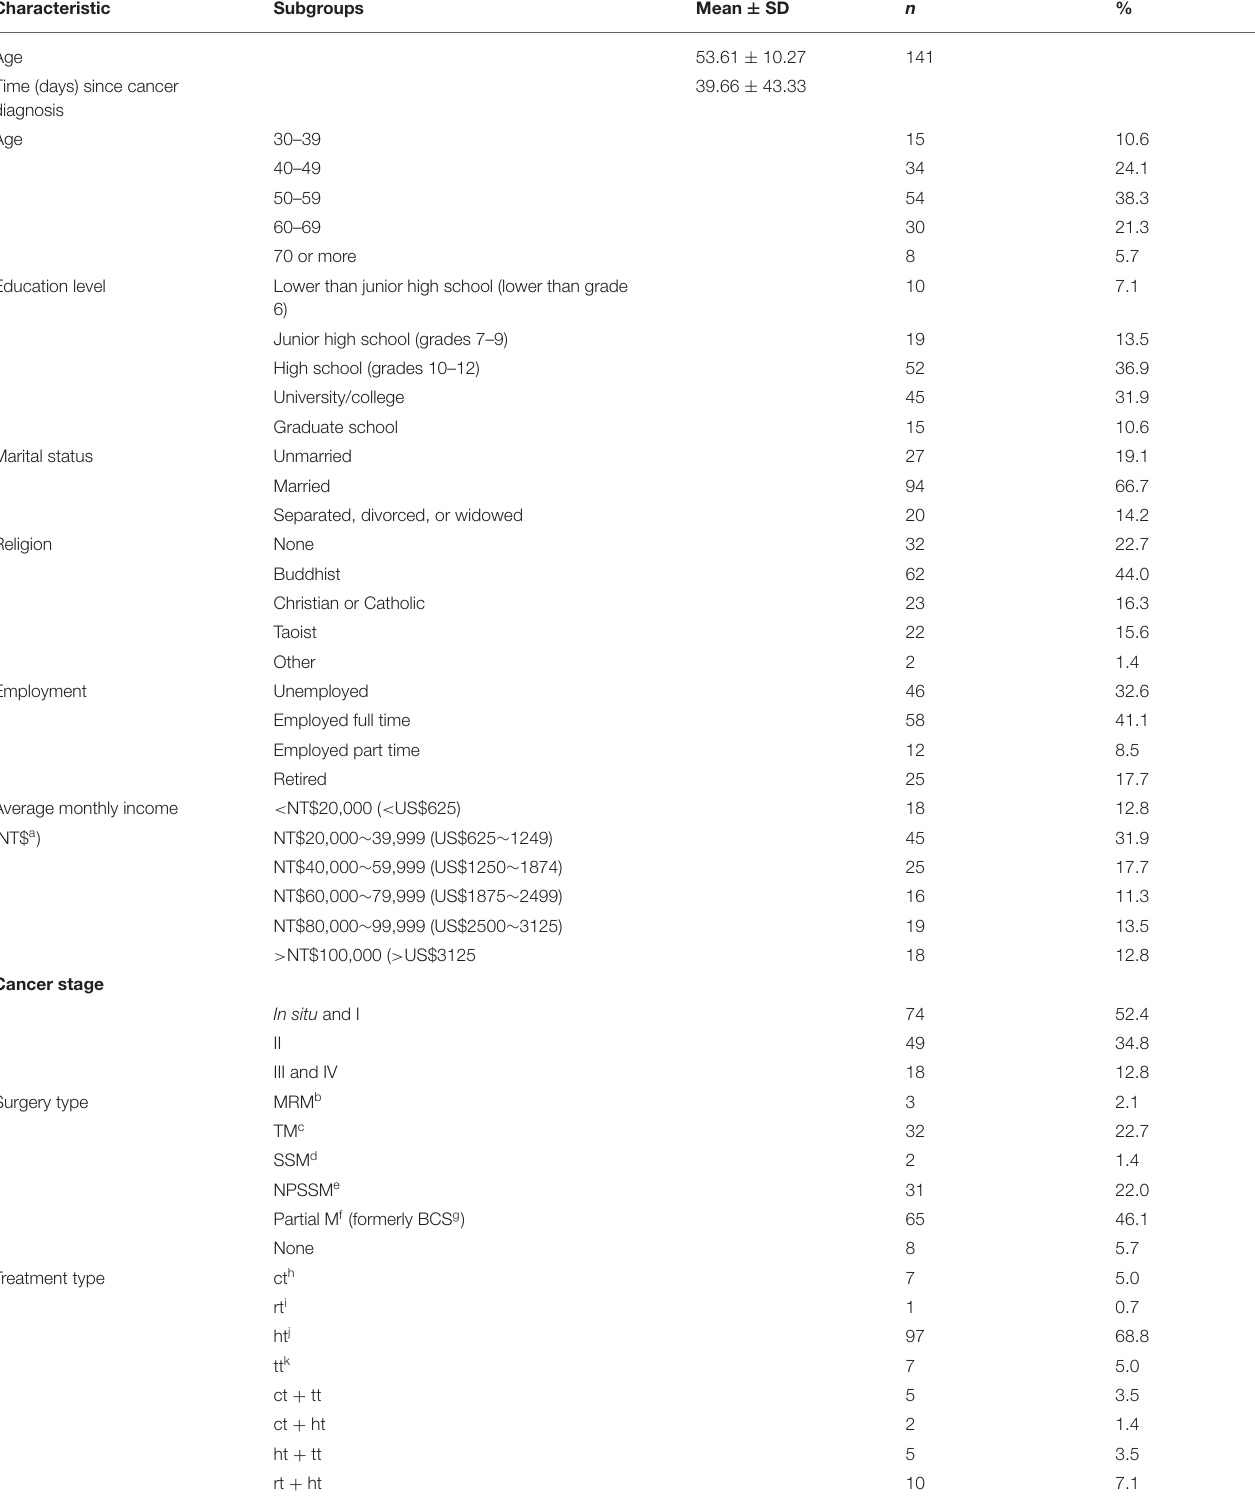
TABLE 1 | Demographic and disease characteristics of subjects ( n =